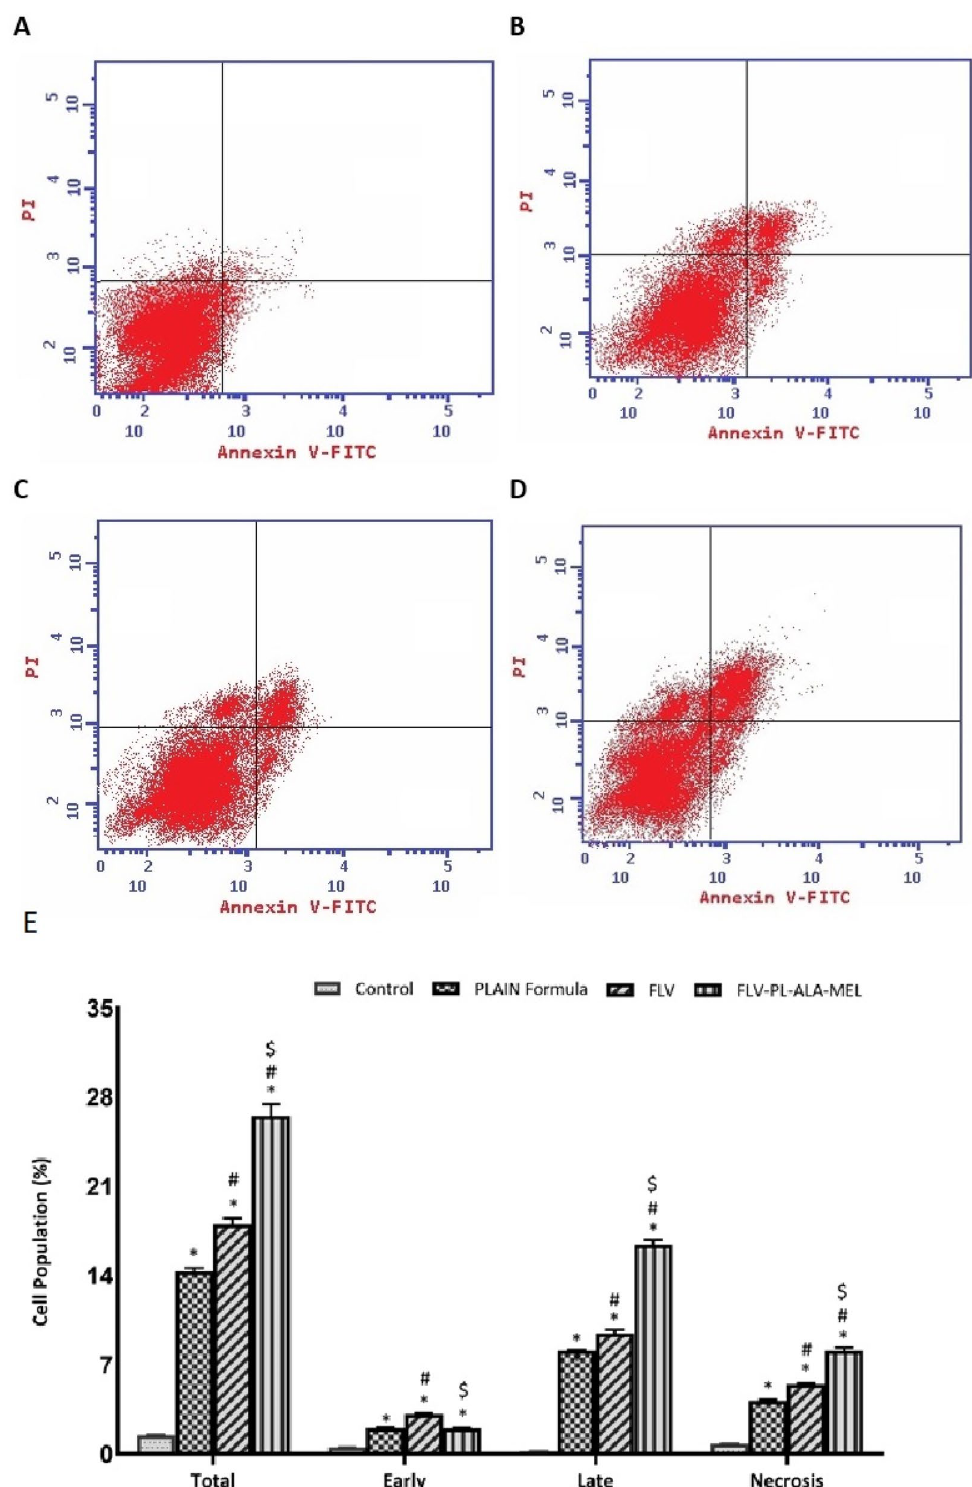
Figure 7. The effect of plain formula, FLV raw and FLV-PL-ALA MEL treatments, on apoptotic/necrotic Caco2 cells. Early refers to the early phase (apoptotic) while late denotes the late phase. On the other hand, total denotes the combination of necrosis and apoptosis. With a view to making more than one comparison, we used the Tukey post hoc test. *Significantly different versus control (p < 0.05). # Significantly different versus Plain formula (p < 0.05). $ Significantly different versus FLV